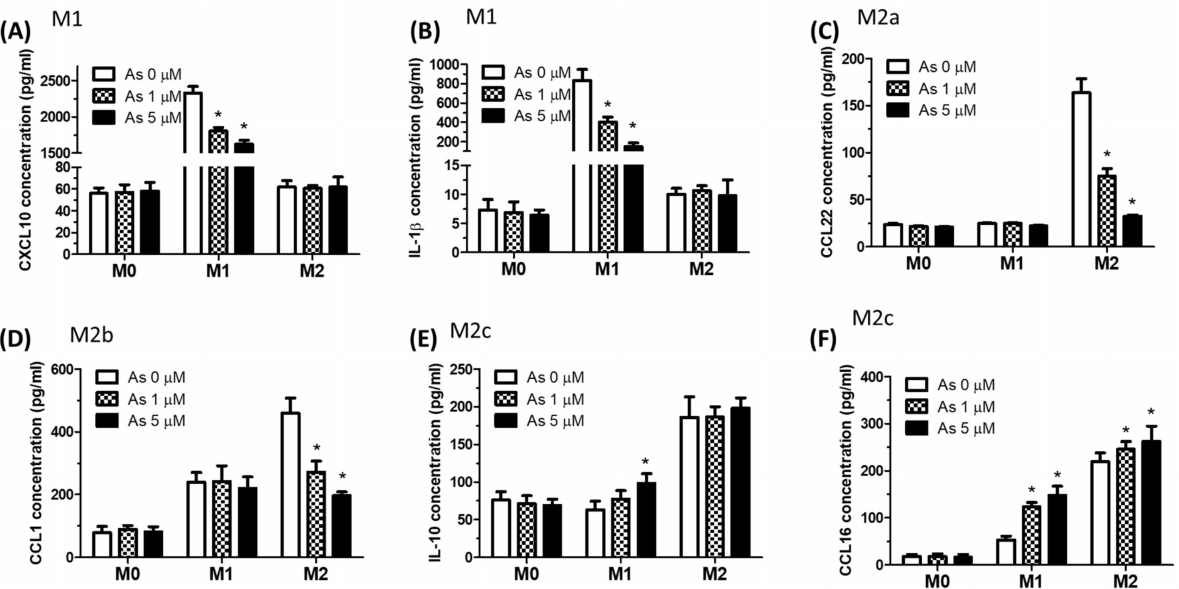
Figure 2. Arsenic increases M2c-asscoated cytokines/chemokines. Supernatants from arsenic- treated M0/M1/M2 M1 cells (24 h) were collected for testing: ( A ) M1 chemokine CXCL10, ( B ) M1 cytokine IL-1 β , ( C ) M2a chemokine CCL22, ( D ) M2b chemokine CCL1, ( E ) M2c chemokine CCL16, and ( F ) general M2 chemokine IL-10. These chemokines/cytokines were tested by ELISA. * p < 0.05, arsenic-treated vs. untreated, by the Kruskal–Wallis test (N =